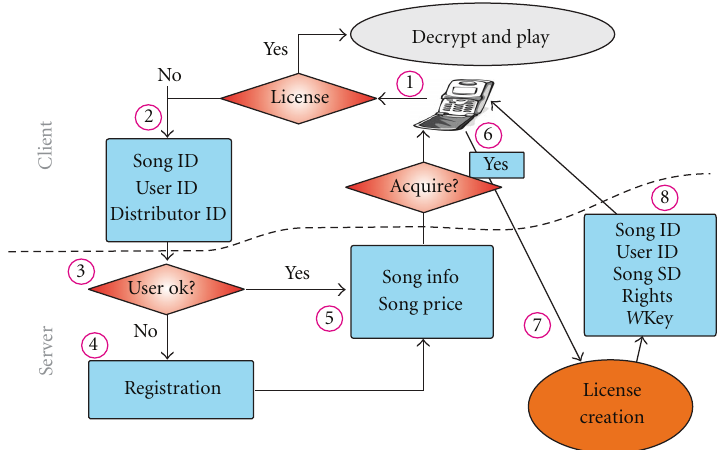
Figure 3: License file